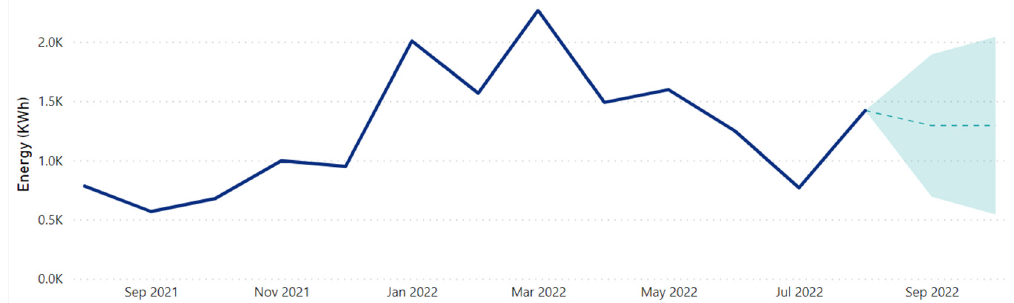
Figure 14. Energy consumption forecast for Operation 2.